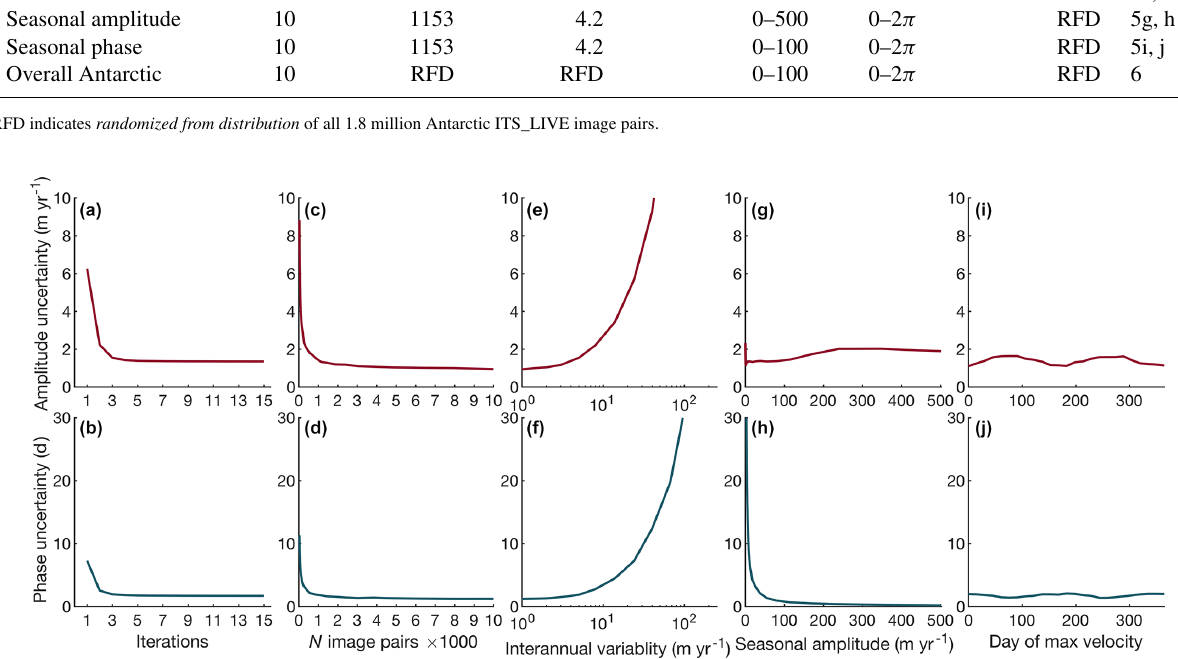
Figure 5. Sensitivity test results. The tests outlined in Table 1 indicate that (a, b) amplitude and phase errors level off after the first few iterations of removing interannual variability and solving for seasonal variability; (c, d) at least 500 to 1000 image pairs are necessary for the most accurate, stable solutions; (e, f) strong interannual variability can drastically affect seasonal amplitude and phase detection; (g) seasonal-amplitude measurement uncertainty is independent of the seasonal ice velocity amplitude itself, but (h) seasonal phase is measured most accurately when the seasonal ice velocity amplitude is strong; and (i, j) although some faint residual effects of the seasonal bias in sampling persist after 10 iterations, amplitude and phase accuracy are effectively independent of the timing of the seasonal ice velocity